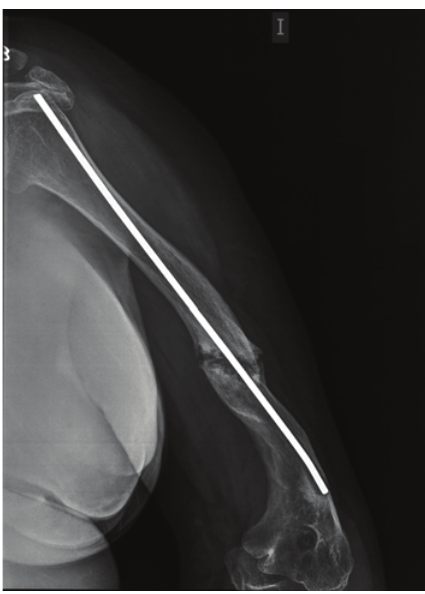
Figure 1: Intramedullary nail placed on the left humerus fracture.